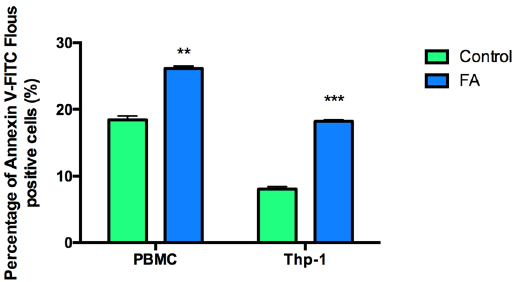
Figure 2. Translocation of PS in PBMCs and Thp-1 cells. FA induced PS externalization in both PBMCs and Thp-1 cells. Data are expressed as mean ± SD. ** p < 0.005 relative to respective control; *** p < 0.0001 relative to respective control.